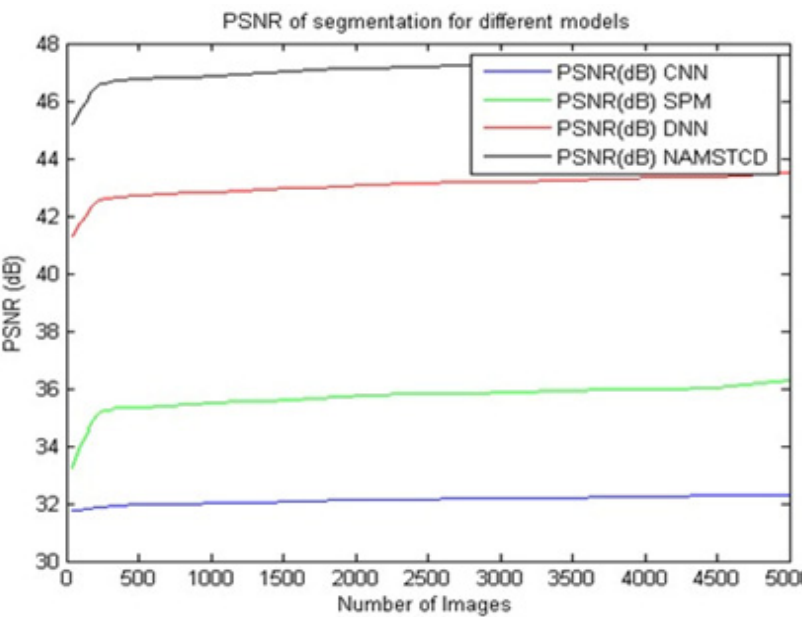
Figure 8. PSNR of classification for different models.